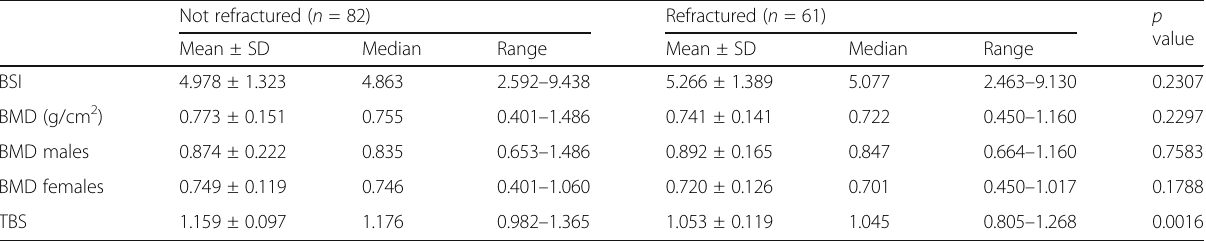
Table 1 Dual-energy x-ray absorptiometry in 143 patients with a fracture at baseline: bone strain index (BSI), lumbar bone mineral density (BMD) and trabecular bone score